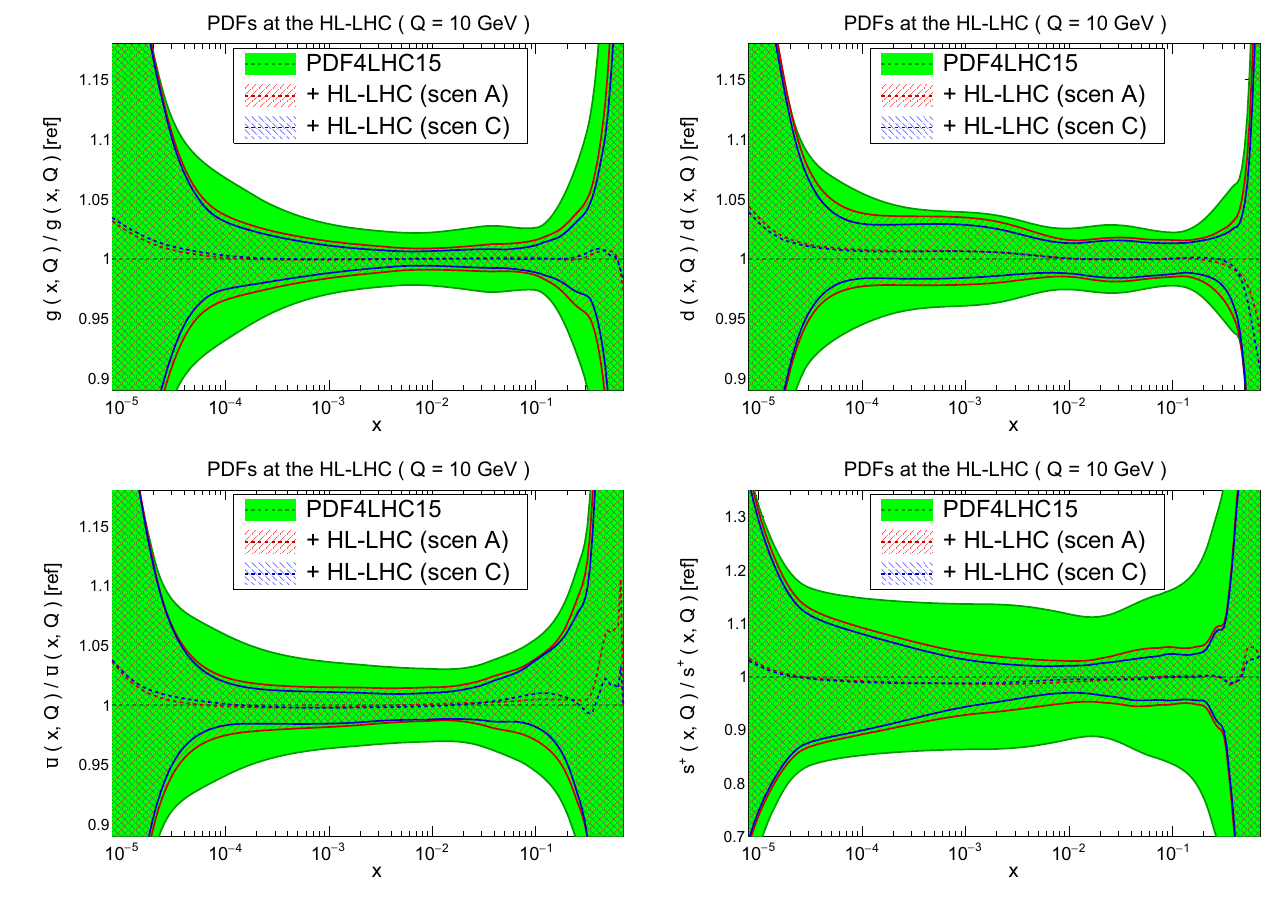
malized to the central value of the PDF4LHC15 baseline. The bands correspond to the one–sigma PDF